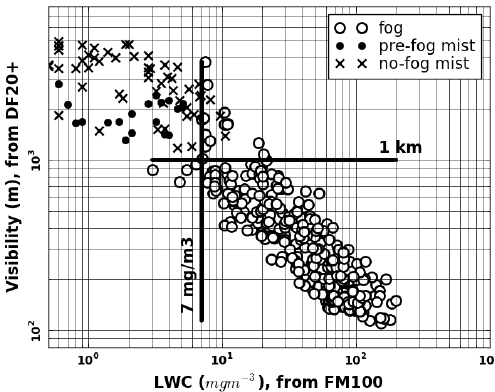
Figure 4. Relationship between visibility, observed by DF20 + , and LWC, observed by FM100, during three regimes in November 2011 at